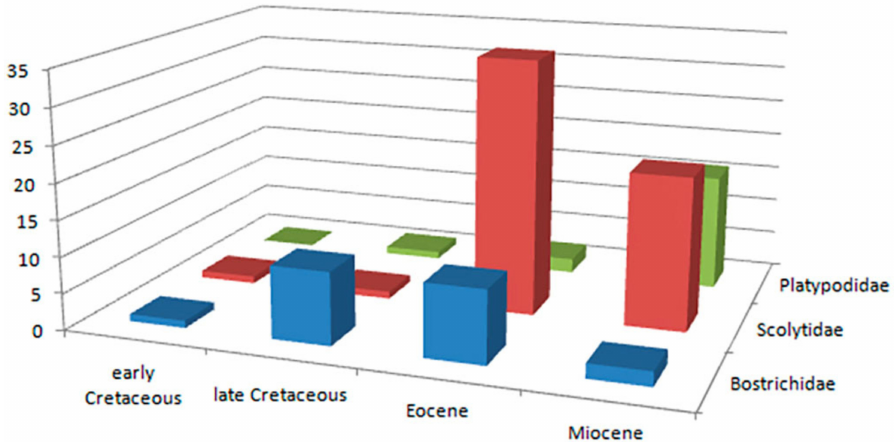
Figure 6. Species diversity of the auger, bark, and ambrosia beetles in the fossil